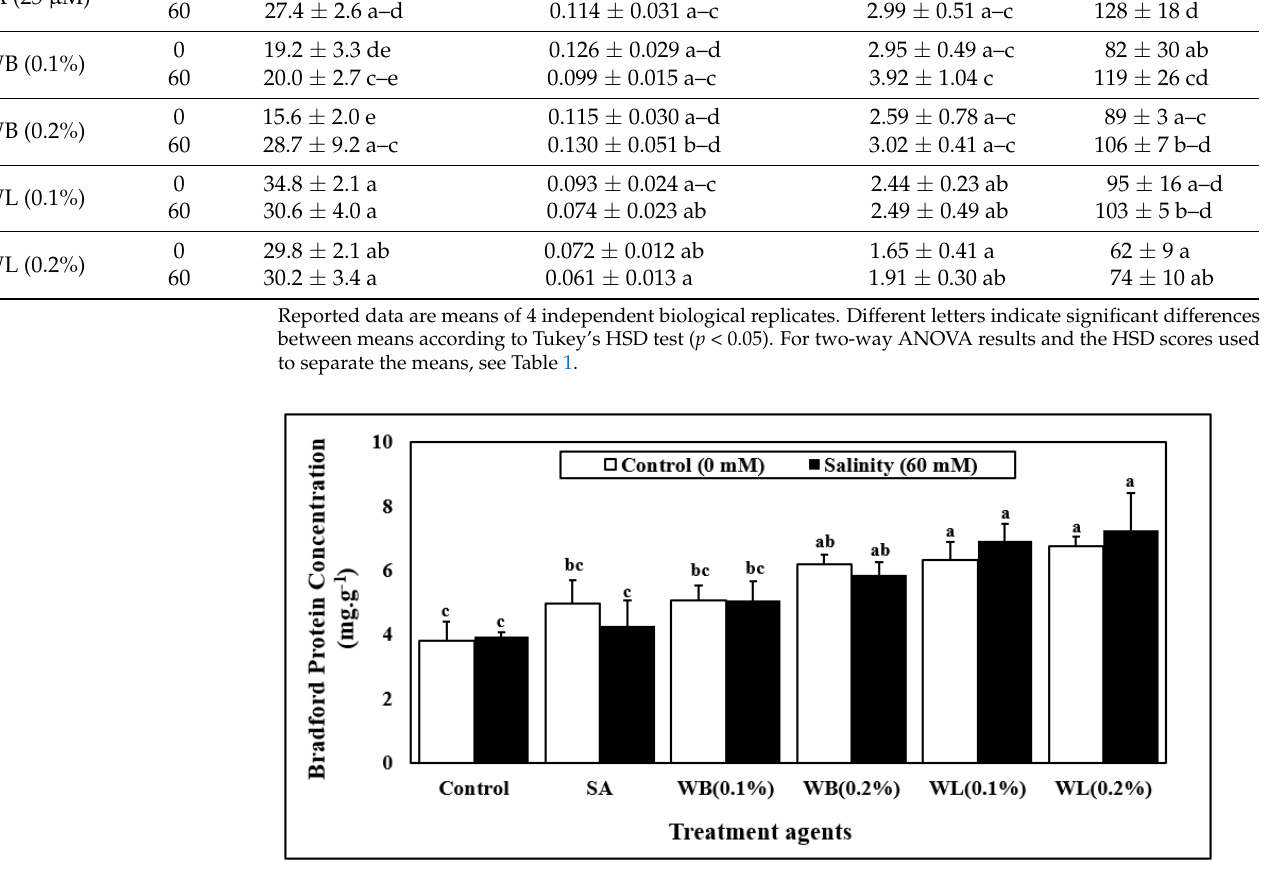
Figure 4. Changes in average protein concentration (590/450) (mg. g − 1 ) of 30 day-old hydroponically grown maize ( Zea mays cv. Caramelo) shoots in response to salinity (non-salinity stress, 0 mM; salinity stress, 60 mM) and biostimulant applications (SA, salicylic acid (25 µ M); WB, willow bark extract (0.1% or 0.2% w/v ); WL, willow leaf extract (0.1% or 0.2% w/v )). Reported data are means of 4 independent biological replicates. Different letters indicate significant differences between means according to Tukey’s HSD test ( p < 0.05). For two-way ANOVA results and the HSD scores used to separate the means, see Table